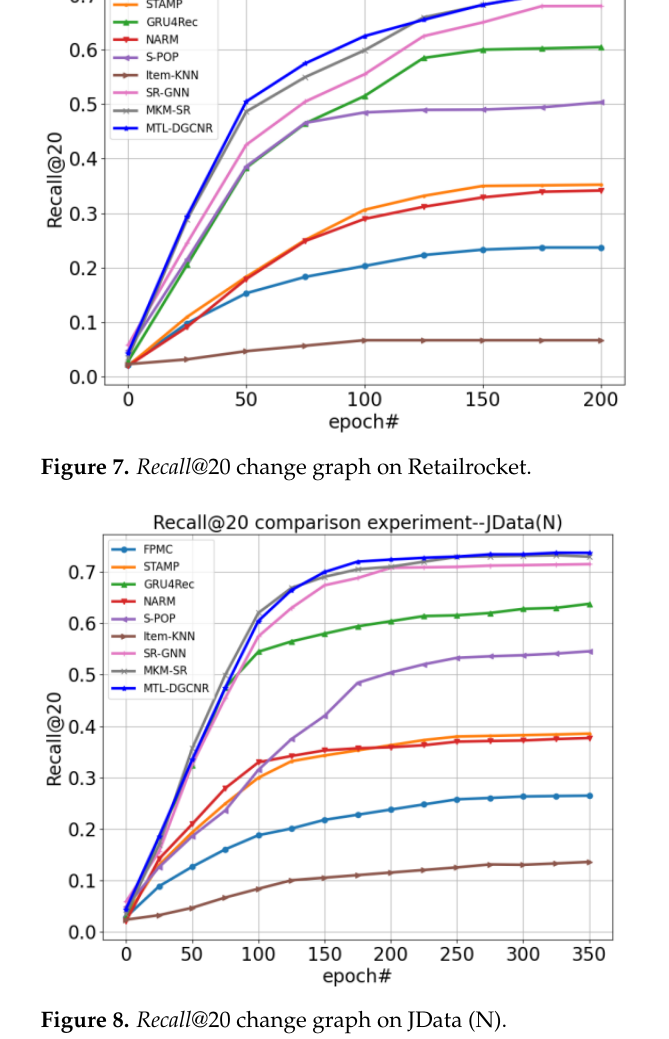
Figure 8. Recall@ 20 change graph on JData (N).